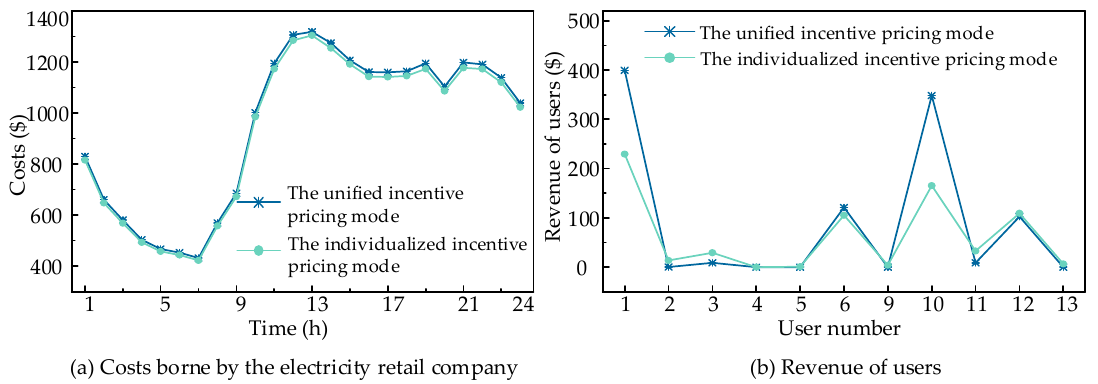
Figure 9. Comparison of costs borne by the electricity retail company (a) and revenue of users (b) under the unified and individualized incentive pricing mode. the unified and individualized incentive pricing